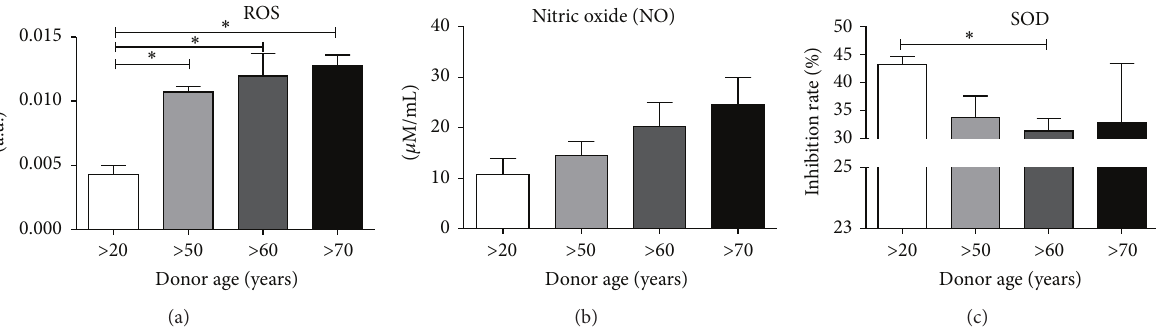
Figure 5: Levels of oxidative stress in hASCs. (a) Reactive oxygen species, (b) nitric oxide, and (c) superoxide dismutase levels. Results expressed as mean ± SD. ∗ 𝑝 value <